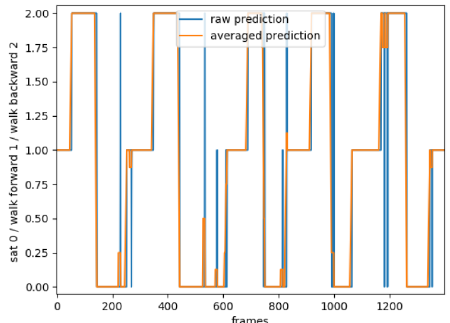
Figure 16. This figure shows the predictions for the activities performed during the exercise, using the LSTM, while walking to the right and left, before ending seated. These steps are the repeated in